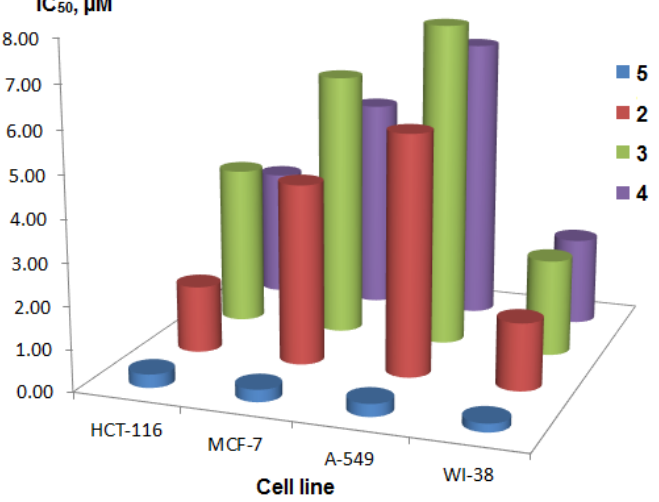
Figure 4. Survival of cell lines HCT-116, MCF-7, A-549 and WI-38 in the presence of compounds 2-5